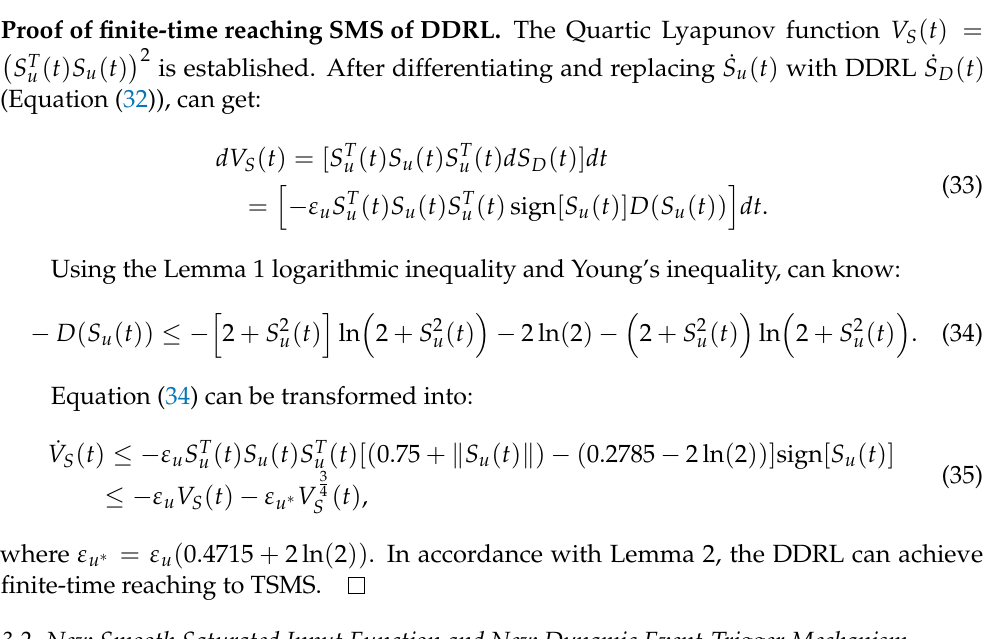
Figure 4. Schematic diagram of different reaching laws.